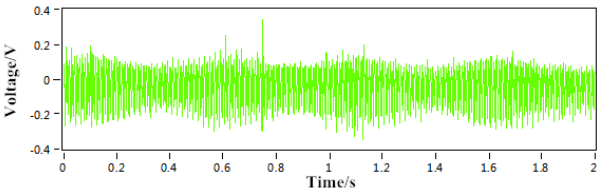
Figure 10. The vibration signal of the fault motor.